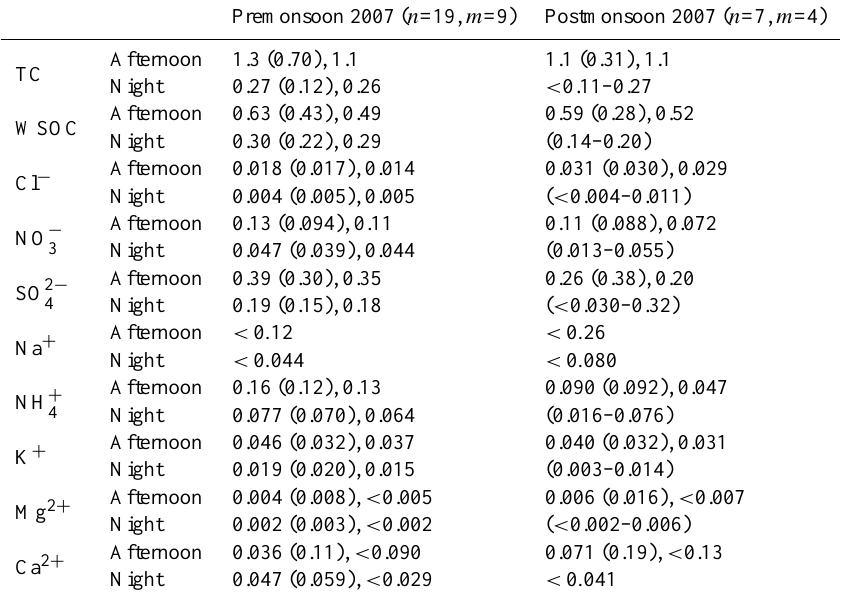
Table 2. Concentrations (µg/m 3 ) of the chemical species determined on PM 1 samples. Statistics are provided for the periods April–May 2007 (Premonsoon) and October–November 2007 (Postmonsoon) and differentiating between afternoon and night-time samples. The number of daytime and night-time samples analyzed in each period of the year are indicated by “ n ” and “ m ”, respectively. Data are reported in the format: average (standard deviation), median. However, for the sets including ≤ 4 samples, only the range of variation is given: (min– max). Notice that the concentrations were calculated using actual measured sampled air volumes. To obtain the concentrations in standard conditions, the values must be multiplied by a factor of 1.8.